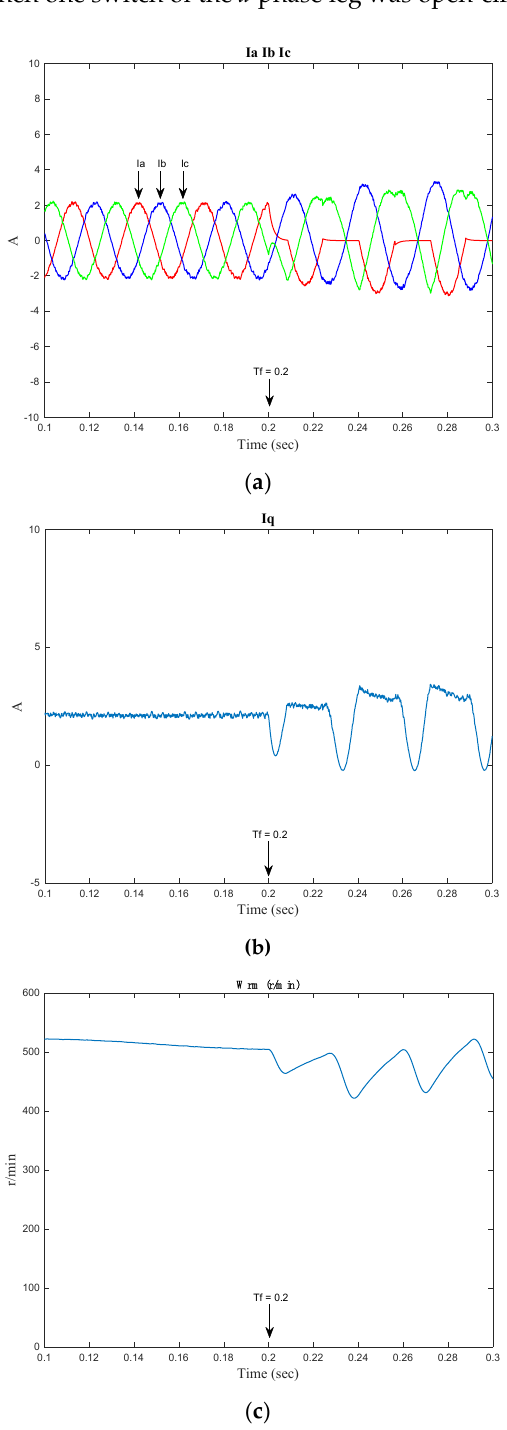
Figure 12. Simulated results of the a -phase open-circuited without using the fault-tolerant method: ( a ) three-phase currents; ( b ) q -axis current; ( c ) speed.